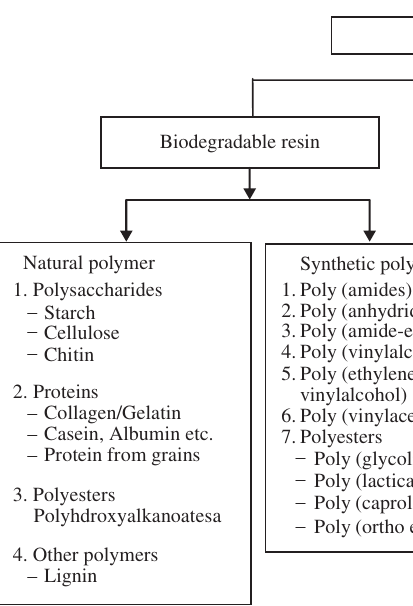
Figure 1: Classification of biodegradable resin and